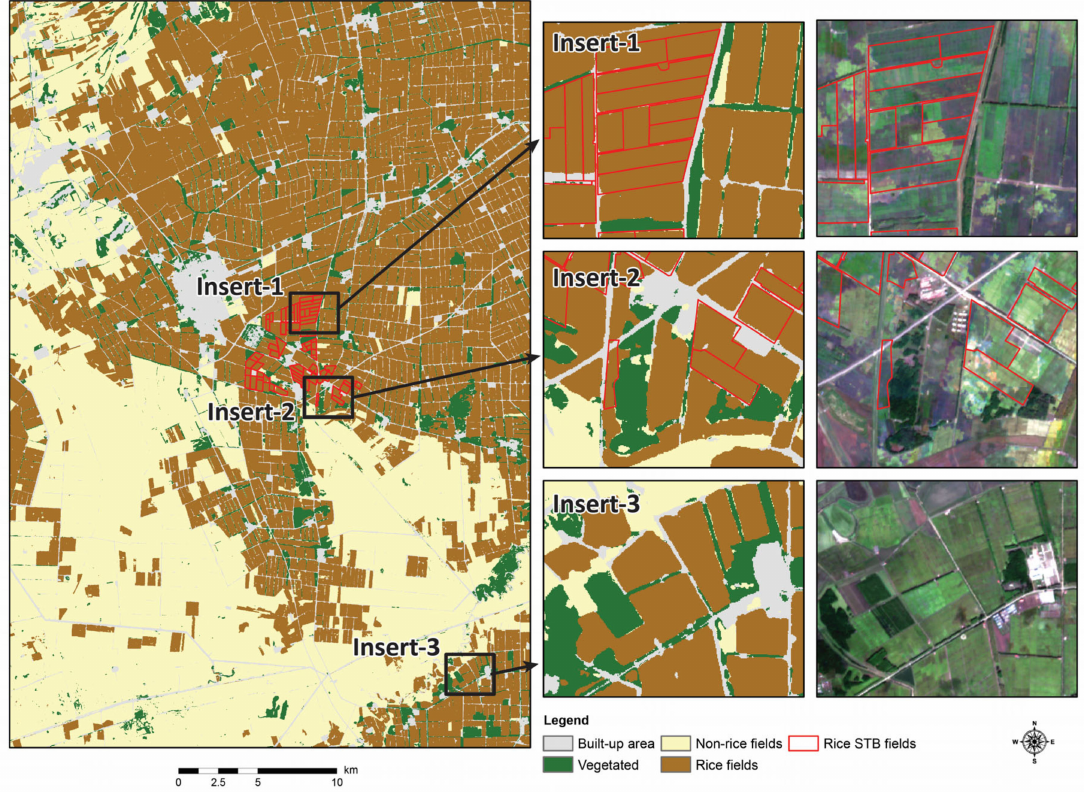
Figure 4. Optimal U-Net segmentation generated from a combination of Sentinel 2 multispectral and Sentinel-1 dual polarization bands (Dataset 4). The three insert maps represent mapped paddy rice fields and their corresponding Sentinel-2 image